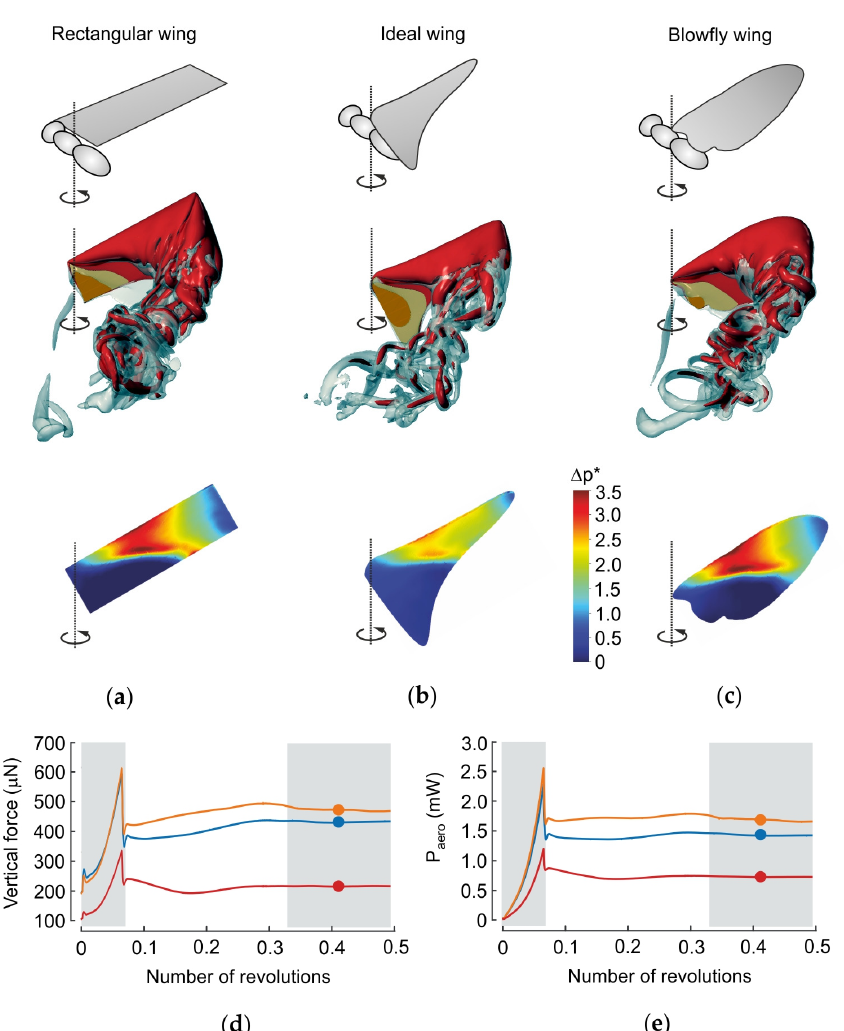
Figure 3. Aerodynamics of revolving wings. ( a – c ) Upper row: aerodynamic characteristics of three flat, continuously revolving wings (rectangular wing, ideal wing for rotation, wing of a blowfly). Middle row: data show iso-surface with vorticity magnitude of 75 s − 1 (grey) superimposed on a vorticity iso-surface with 150 s − 1 (red). The flow is shown after ~0.4 revolutions after motion onset. Lower row: pressure difference ( Δ p *) between dorsal and ventral wing sides, and normalized to the uniform wing loading pressure. The latter value is equal to body weight divided by the surface area of two wings. ( d – e ) Time evolution of vertical lift in d and aerodynamic power in e . After motion onset (grey, left), lift and power stabilize approximately after 0.3 revolutions (grey, right). Dots are mean values calculated from ~0.32–~0.5 revolutions (grey, right). Wing length and area are identical in all wings. For numerical modeling see [83] . Orange, rectangular wing; blue, wing of Calliphora vomitoria ; and red, ideal-shaped wing.